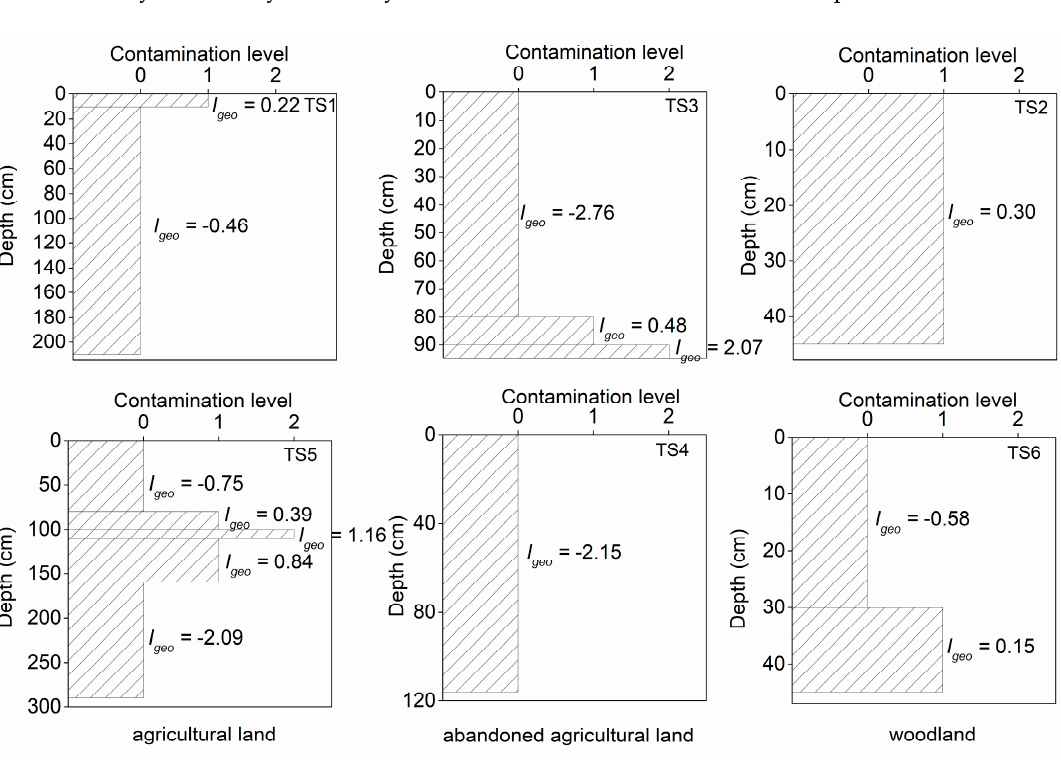
Figure 8. The mercury contamination level in the soil profiles of different land uses.